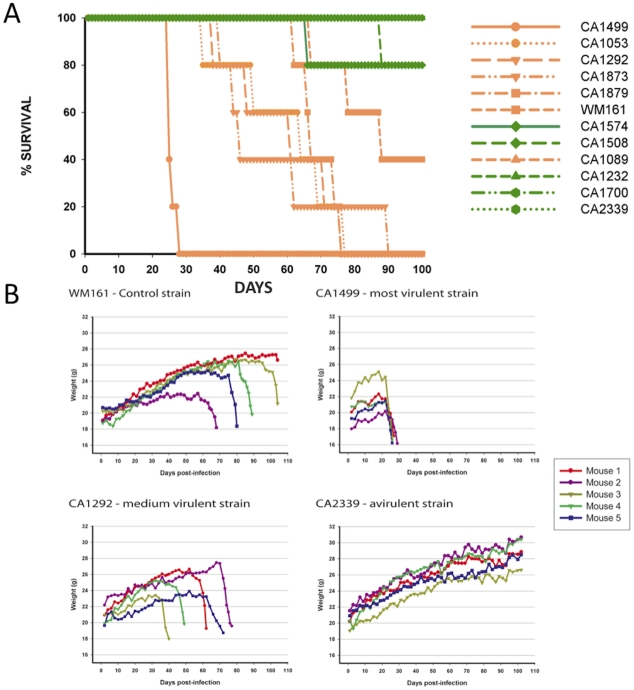
Isolates from the VGIIIa group exhibit increased virulence compared to VGIIIb in an in vivo murine model of infection.A) Groups of five animals were each infected with an infectious inoculum of 1.0×105 cells, and the survival of animals plotted against days post-infection. The legend is arranged from most virulent (top) to least virulent (bottom, based on survival). VGIIIa isolates are indicated by orange coloration and VGIIIb isolates are indicated by green coloration. B) C. gattii infections cause notable weight loss associated with the virulence level of strains. BALB/c mice were infected with 1.0×105 yeast cells via the intranasal instillation route. The weight of each animal was monitored every other day after infection while asymptomatic. When the animals began to exhibit symptoms of infection, weight was measured daily and plotted.